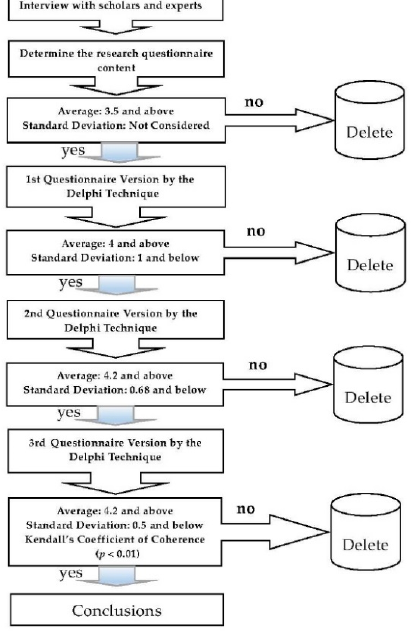
Figure 6. Steps to prepare the questionnaire by the Delphi technique.